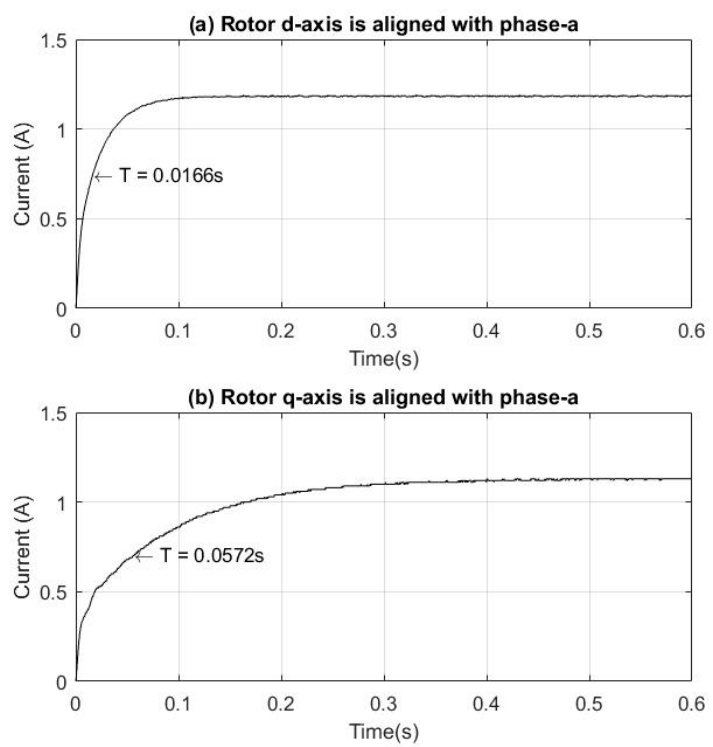
Figure 17. Step response of the tested motor.